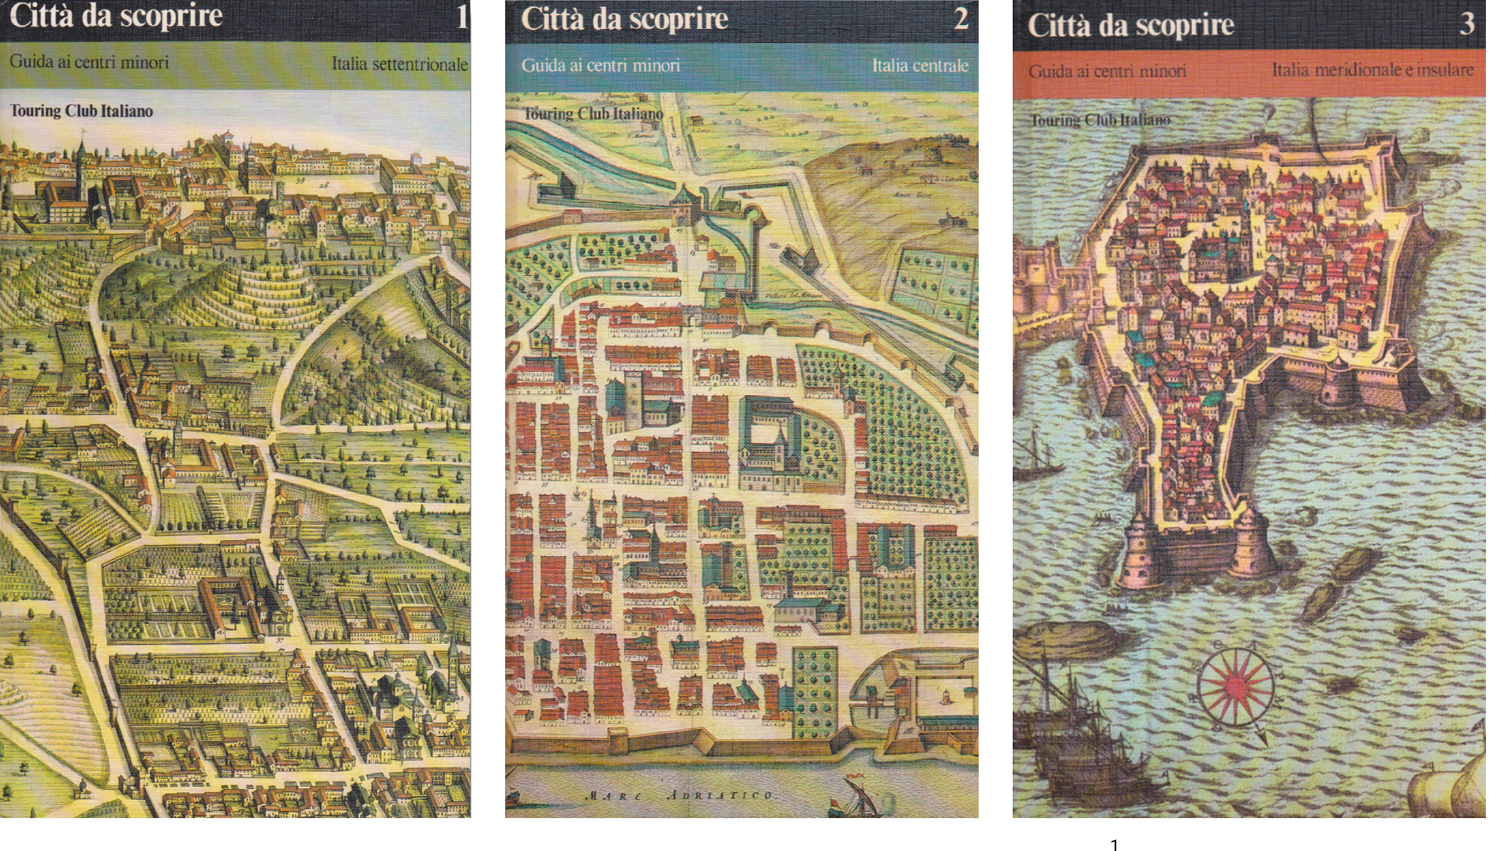
Fig. 1 The covers of the three vol- umes of the collection Città da scoprire. Guida ai centri minori , directed by Lucio Gambi and published by the Touring Club Italiano between 1983 and 1985. Courtesy of the Archivio Tour- ing Club